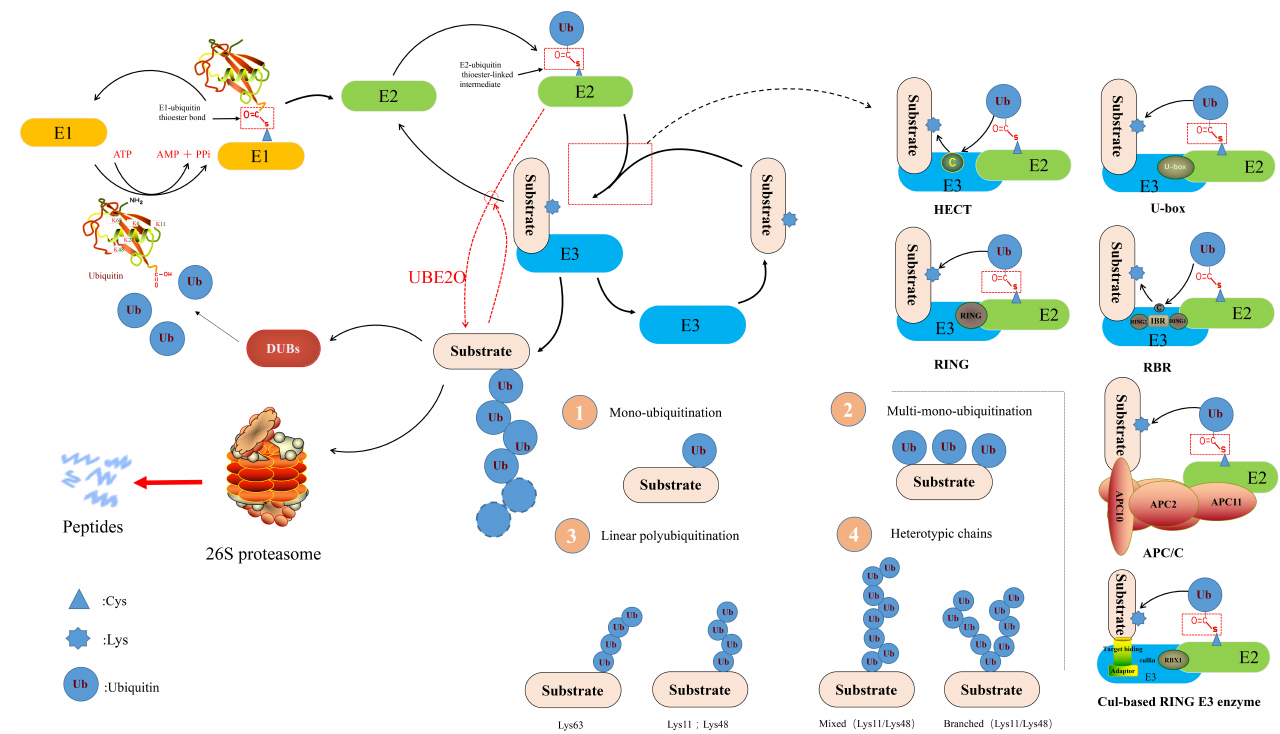
Figure 1. A schematic diagram of the ubiquitin-proteasome pathway (refer to [13]). Ubiquitin (Ub) is activated by ubiquitin-activating enzyme in an adenosine-triphosphate-dependent manner. Ubiquitin-activating enzyme hydrolyzes adenosine-triphosphate and forms a complex with Ub. Subsequently, Ub is transferred to one of many different E2s. In some reactions, E2 (UBE2O) can directly ubiquitinate the substrate, while others need the help of ubiquitin ligases (E3s). E3s are currently categorized into three families, (i) Homologous to E6-associated Protein C-terminus (HECT), (ii) Really Interesting New Gene (RING), and (iii) U-box Domain [25]. The Cullin-RING ligases (CRLs), APC/C ligase, and RING-Between-RING ligases (RBRs) all belong to RING E3s. Ubiquitination of substrates occur as mentioned in the three ways: Monoubiquitination, multi-monoubiquitination, and polyubiquitination (including linear polyubiquitination and branched